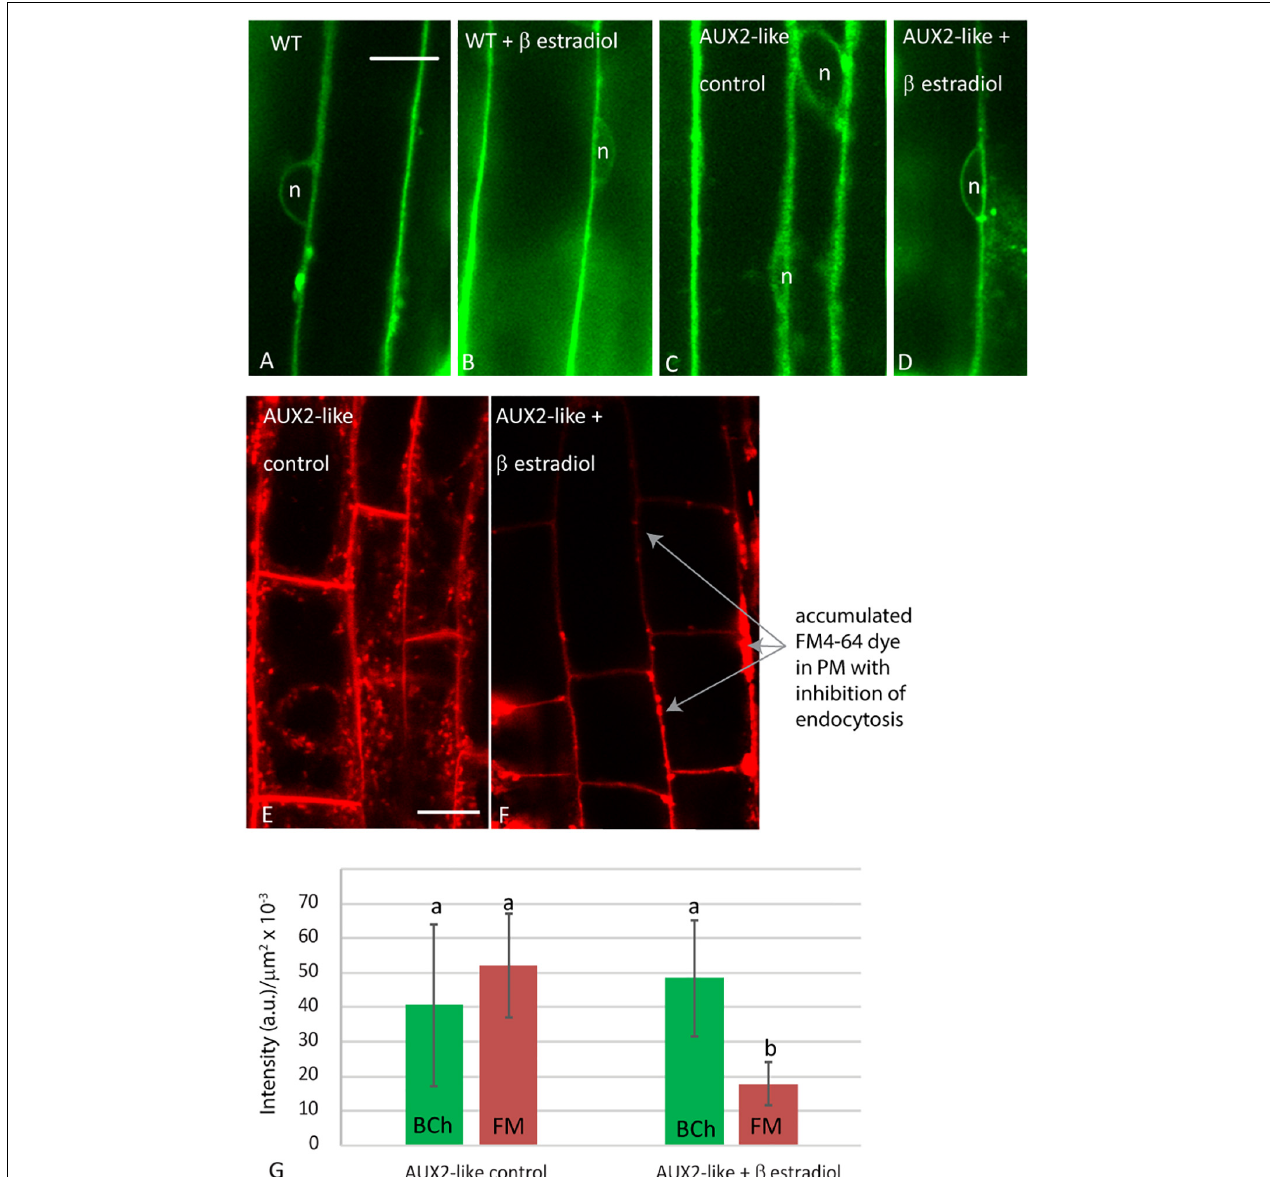
FIGURE 9 | Analysis of uptake in AUX2 expression lines. Confocal micrographs of elongating root cells following (A–D) 30 min labeling with BCh in (A) the wild-type (WT) Arabidopsis line, (B) WT line pretreated with 9 mM β -estradiol, (C) the AUX2 line, and (D) the AUX2 line pretreated with 9 mM β -estradiol; (E–F) 30 min labeling with FM4-64 in (E) the AUX2 line and (F) the AUX2 line pretreated with 9 mM β -estradiol. (G) Quantitation of label intensity per square micrometer of cytoplasm in four to five different cells in three different plants. (b) column values < 0.05p compared to (a) column values, n, nucleus. Scale bars = 10 µ